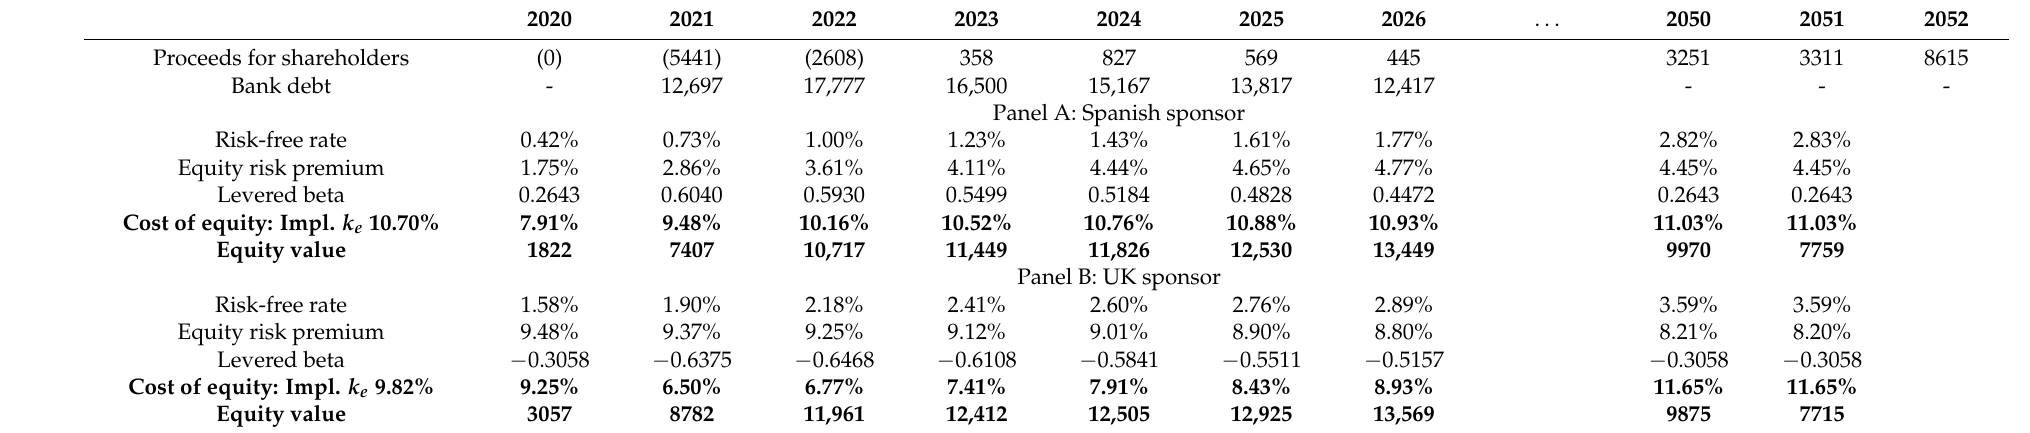
Table 6. Equity valuation and implied cost of equity for the base